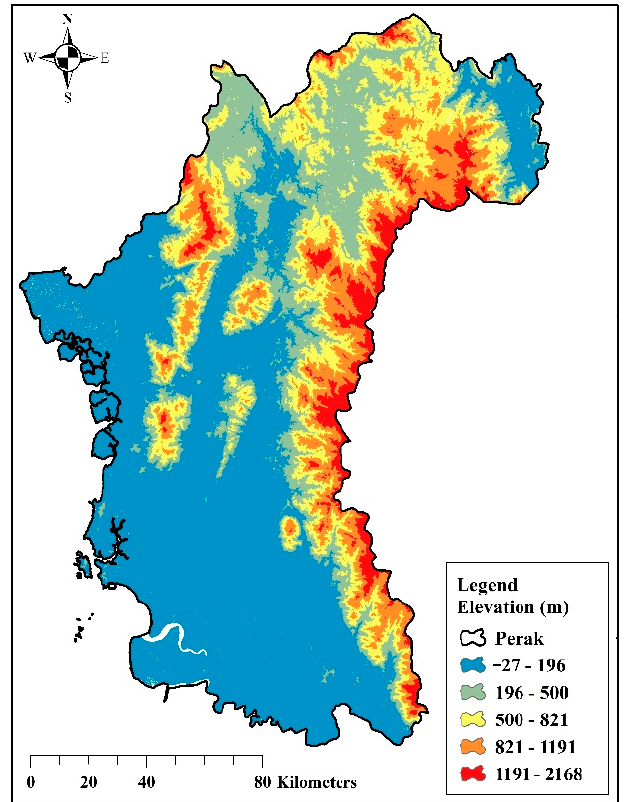
Figure 2. The elevation map of the study area. A slope map of the study area was made in order to estimate the steepness of the region. From the slope map, five classes of distinct steepness were generated. The variation in steepness was based on the topographical features of the study area. The main ranges of steepness in the five classes of the study area were from 0–3.48 ◦ , 3.48–7.67 ◦ , 7.67–11.83 ◦ , 11.83–16.26 ◦ , and 16.26–36.14 ◦ , as shown in Figure 3. The factor of slope steepness has a significant effect on the rate of soil erosion, soil stability, and sedimentation. The amount of soil erosion increases with the increase in slope gradient due to a rise in the velocity of surface runoff